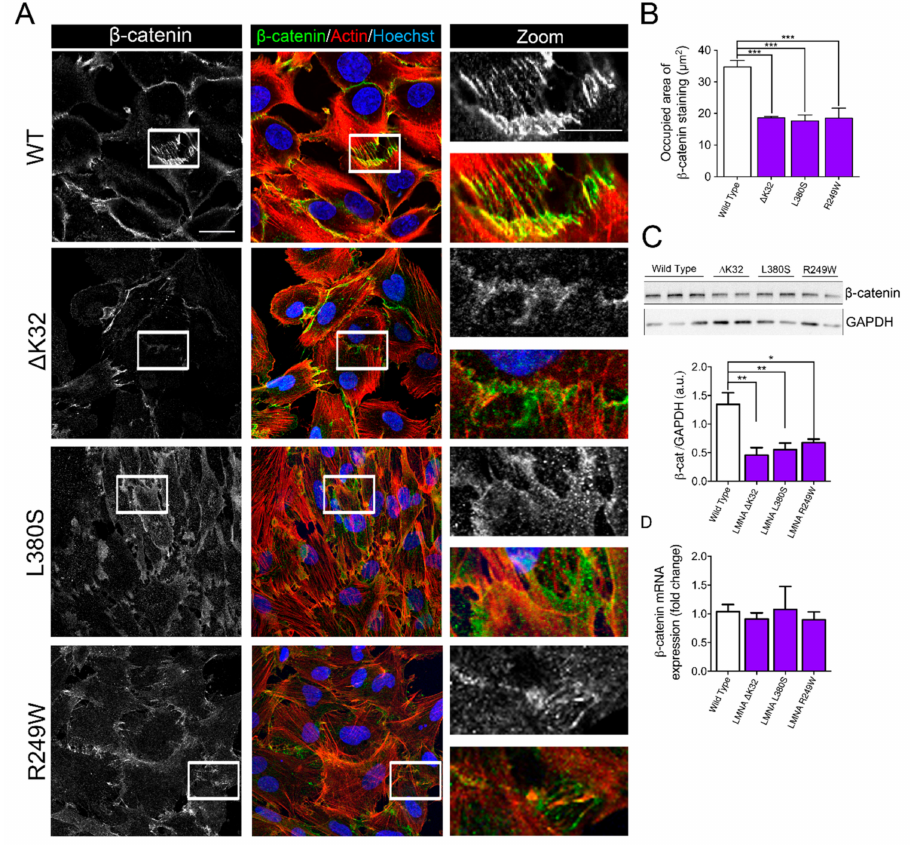
and LMNA -CMD mutant ( ∆ K32, L380S and R249W) muscle cell precursors. Nuclei are stained with Hoechst (blue). Scale bar: 20 µ m. Zoomed region of cell-cell junctions are shown in left panels. Scale bar: 10 µ m. ( B ). Top: Representative Western blot of M-cadherin and GAPDH expression in WT and LMNA mutant myoblasts. Bottom: Quantification of M-cadherin protein levels normalized to GAPDH and expressed as fold change versus WT. Values are means ± SEM, n ≥ 3 from at least 2 separate experiments. * p < 0.005 compared with WT. ( C ) Top: Representative Western blot M-cadherin and α -tubulin expression in WT and R249W myoblasts after 4h-treatment with cyclohexamide (CHX). Bottom: Percentage fold-change in M-cadherin protein levels in WT and mutant myoblasts after CHX treatment. M-cadherin protein levels normalized to β -tubulin. Pooled values of WT (WT1 and WT2) are presented. Values are means ± SEM, n = 3 in WT and mutant cell lines. * p < 0.05 compared with WT. ( D ) mRNA expression of CDH15 normalized to RPLP0 and expressed as fold-changes vs WT. Pooled values of WT (WT1 and WT2) are presented. Values are means ± SEM, n = 3 separate experiments. There was no significant difference between cell lines.